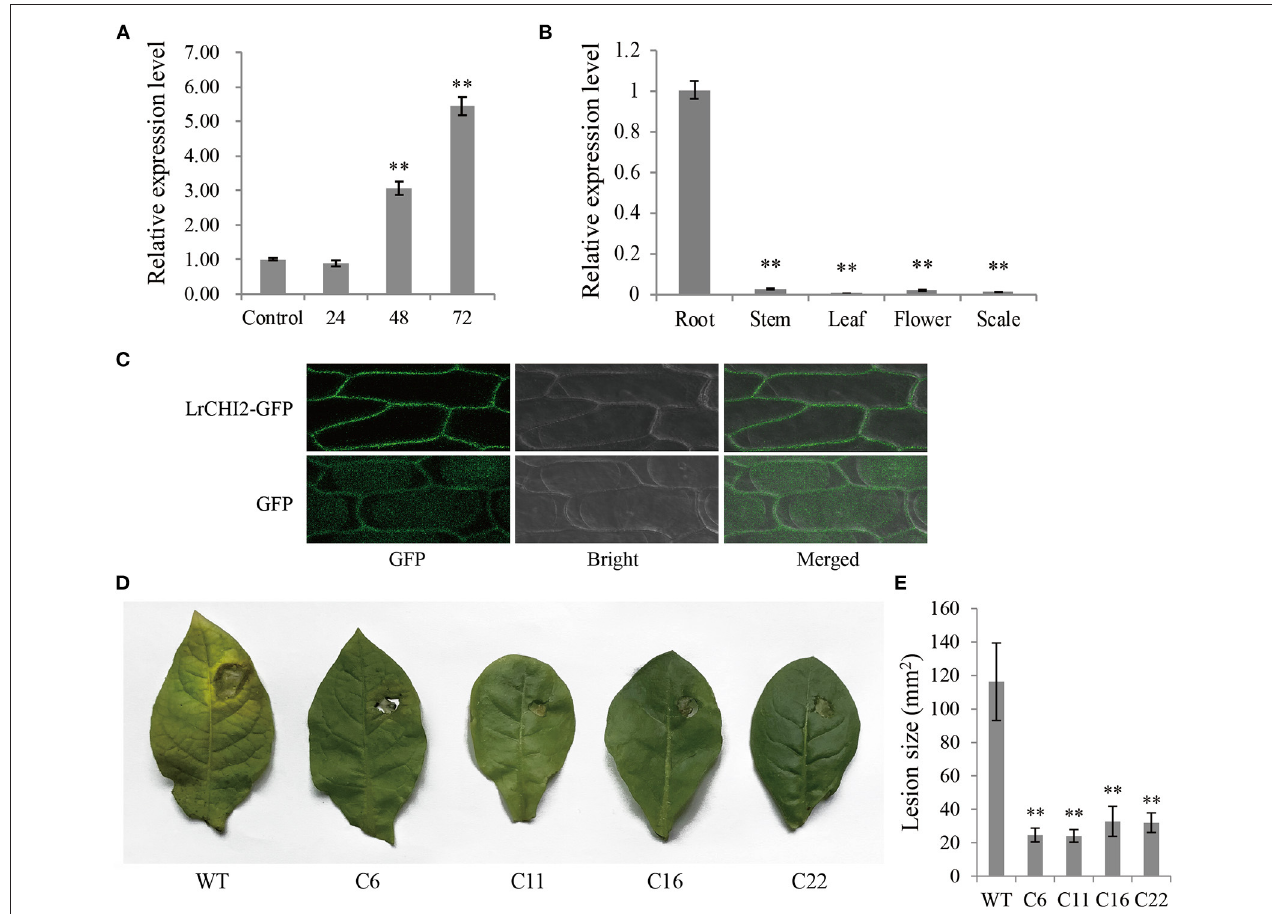
FIGURE 5 | The functional analysis of LrCHI2 . (A) The expression levels of LrCHI2 in L. regale roots after inoculation with F. oxysporum were analyzed by qRT-PCR. The L. regale roots were inoculated with F. oxysporum , and then were collected at 4, 24, 48, and 72 hpi. The roots inoculated with sterile water were used as control sample. (B) The expression levels of LrCHI2 in various tissues of L. regale under normal conditions were analyzed by qRT-PCR. (C) Subcellular localization analysis of LrCHI2-GFP fusion protein. The LrCHI2-GFP fusion protein was transiently expressed in cell wall after genetic transform mediated by A. tumefaciens . GFP, fluorescent light; Bright, white light; Merged, overlaid of fluorescent and white light. (D) The leaf inoculation assay revealed the four T 2 LrWRKY2 transgenic tobacco lines (C6, C11, C16, and C22) showed enhanced resistance to F. oxysporum infection. (E) The lesion areas in the inoculated leaves of the four T 2 generation LrCHI2 transgenic tobacco lines were significantly smaller than that in the WT (** p < 0.01). Bars represent the standard errors of three biological replicates. The statistical analysis was performed with the t test (** p <